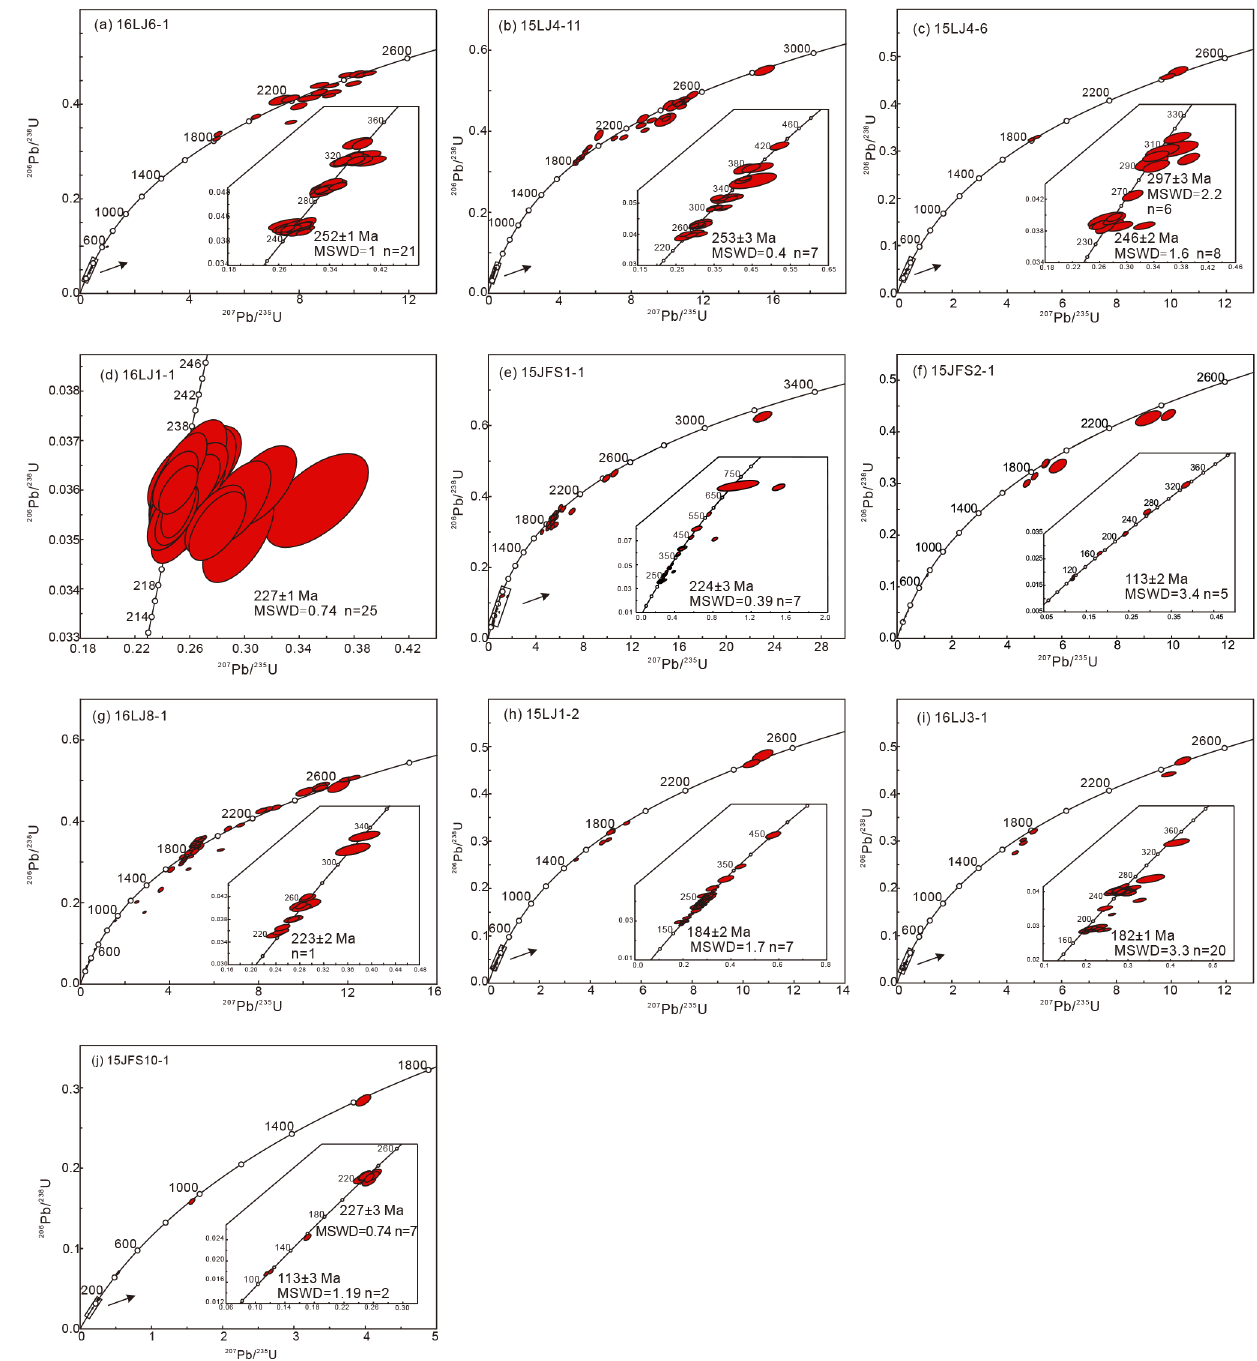
Figure 9. U–Pb concordia diagram for zircon grains from the sedimentary and igneous rocks within early Mesozoic strata.